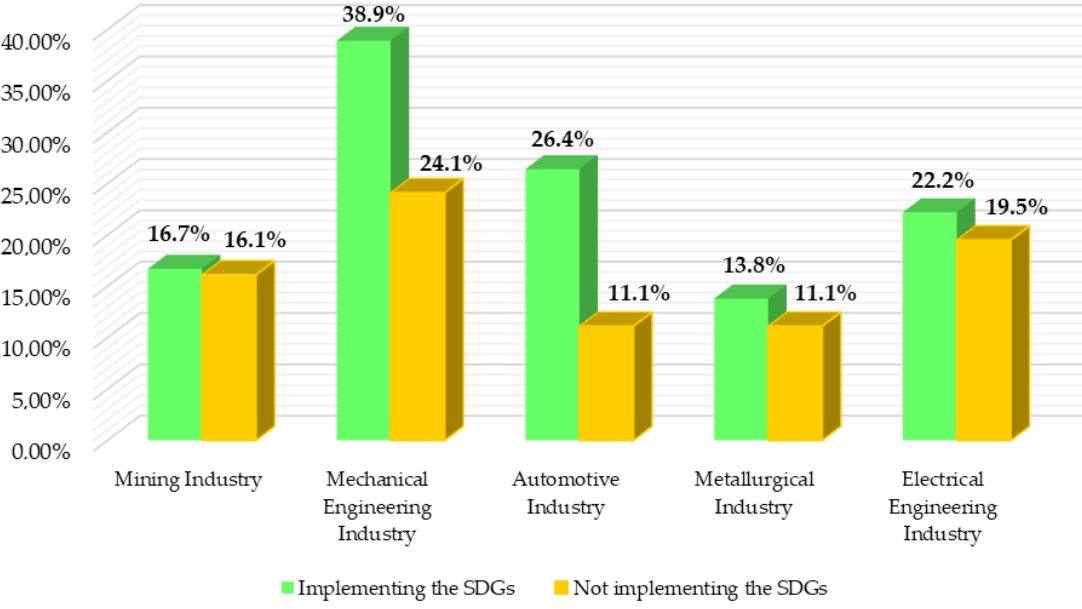
Figure 2. The data visualisation of SDGs implementation in selected industry sectors.